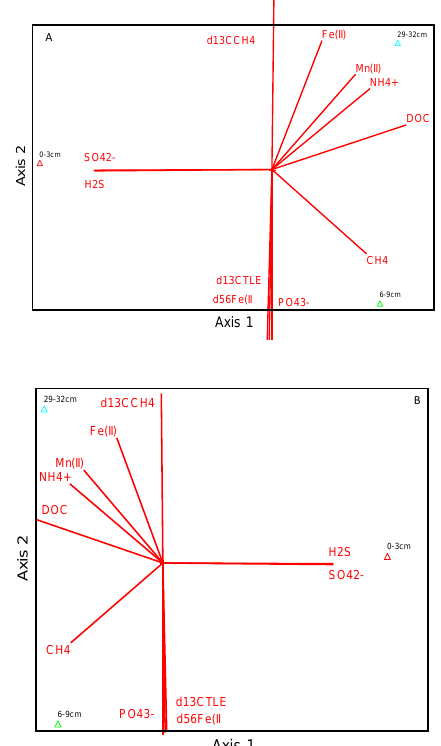
Figure 5. Principal coordinate analysis (PCoA) of the (a) bacte- rial and (b) archaeal community matrix (based on operational tax- onomic units) and vector fitting of the environmental geochemical conditions in the different depth. The bacterial community from the upper layer is labeled with a red triangle, the middle layer is la- beled with a green triangle and bottom layer is labeled with a blue triangle.